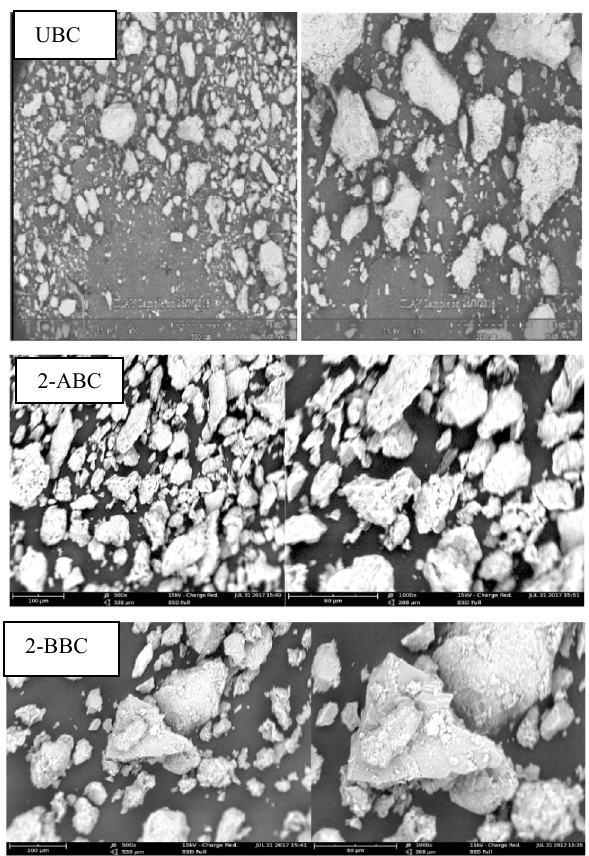
Fig. 3 SEM Micrograph of UBC, 2-ABC and 2-BBC, respectively, at × 500 and × 1000 magnifications